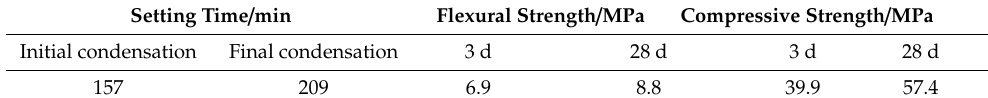
Table 1. Chemical compositions of P.W 52.5 cement. Table 2. Physical and mechanical properties of P.W 52.5 cement.